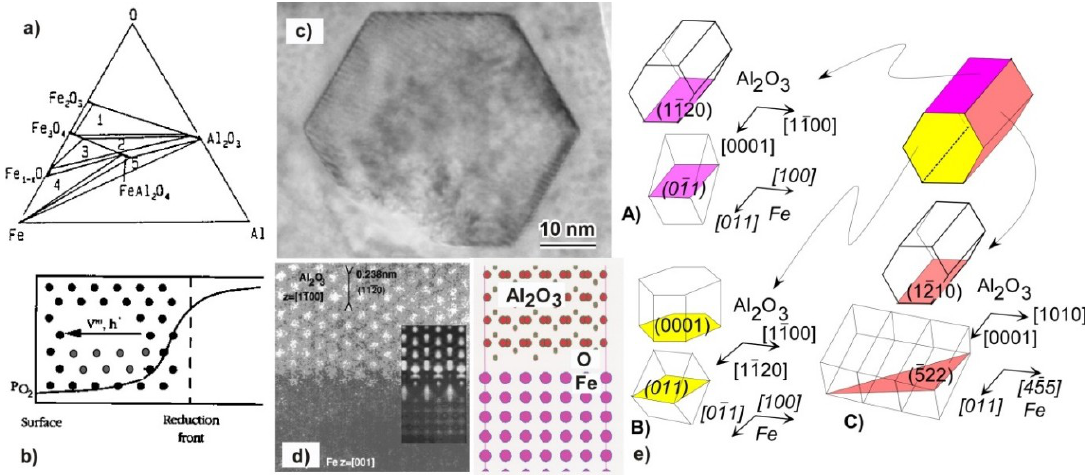
O interface: ( a ) phase 2 3